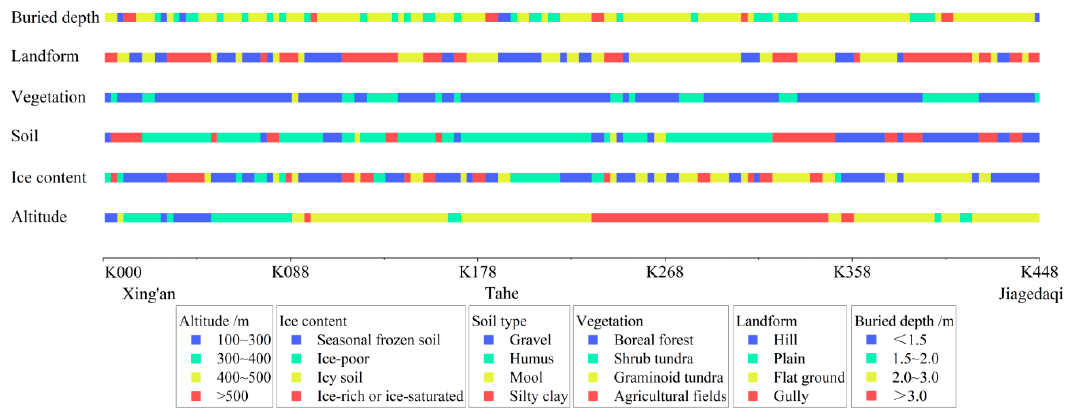
Figure 2. Distribution of the geological and geographic factors along the pipeline (from Xing’an to Jiagedaqi, by Origin 2015).